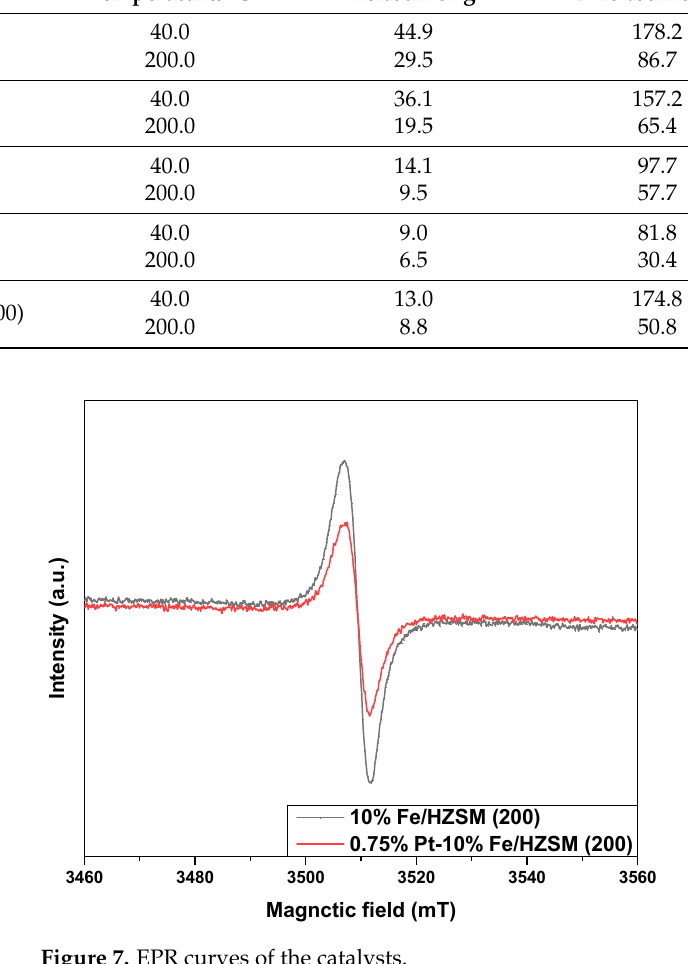
Figure 7. EPR curves of the catalysts.